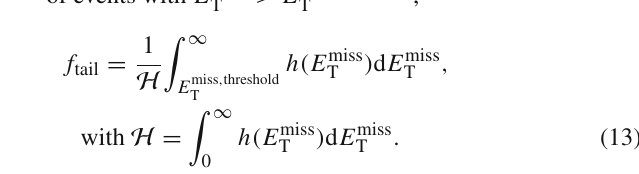
Fig. 9 The E miss resolution measured by RMS miss T the true missing transverse momentum E miss , true W → μν , and t ¯ t samples from MC simulations